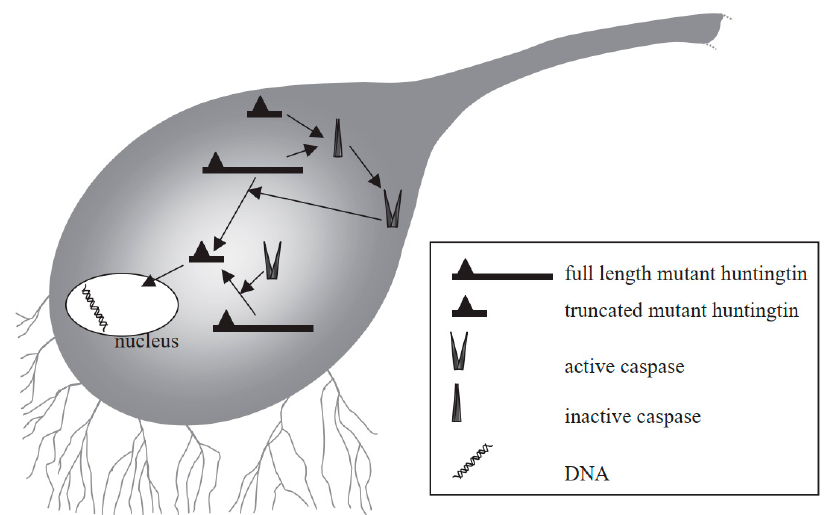
Figure 6. Mechanism of mutant huntingtin-mediated transcriptional dysregulation in Huntington’s disease [177]. Figure reproduced with permission from Ref [177]. Copyright 2003, Elsevier